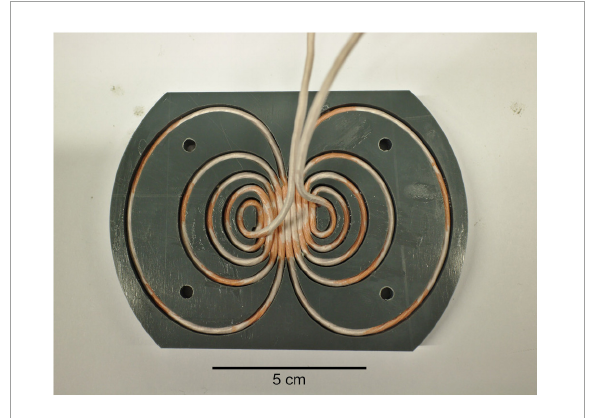
FIGURE1 Photograph of the transcranial magnetic stimulation (TMS)